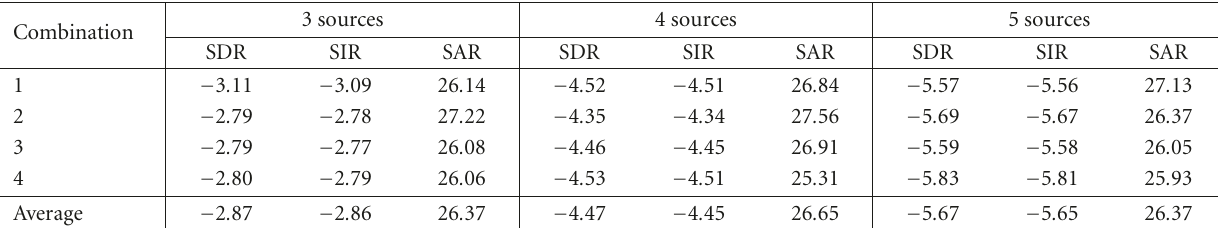
Table 6: Input SDR,SIR, and SAR for di ff erent numbers N of